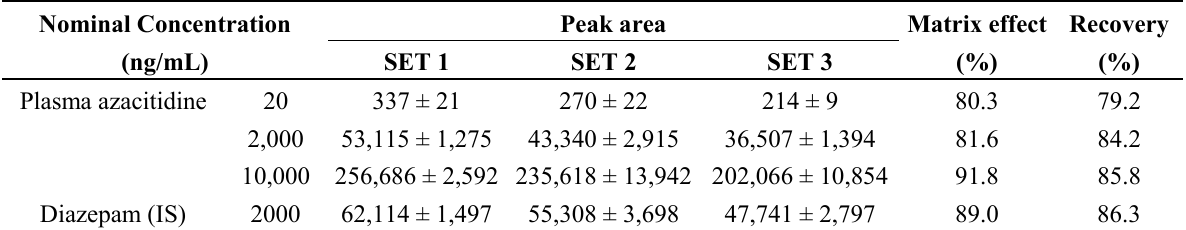
Table 1. Matrix effects and recoveries of azacitidine and diazepam (IS) in rat plasma after sample preparation. The data are presented as means ± S.D. (n = 6). Matrix effect (%) = (SET 2/SET 1) × 100; Recovery (%) = (SET 3/SET 2) × 100; SET 1: the peak areas obtained from neat solution standards; SET 2: the peak areas from standards spiked after extraction; SET 3: the peak areas from standards spiked prior to